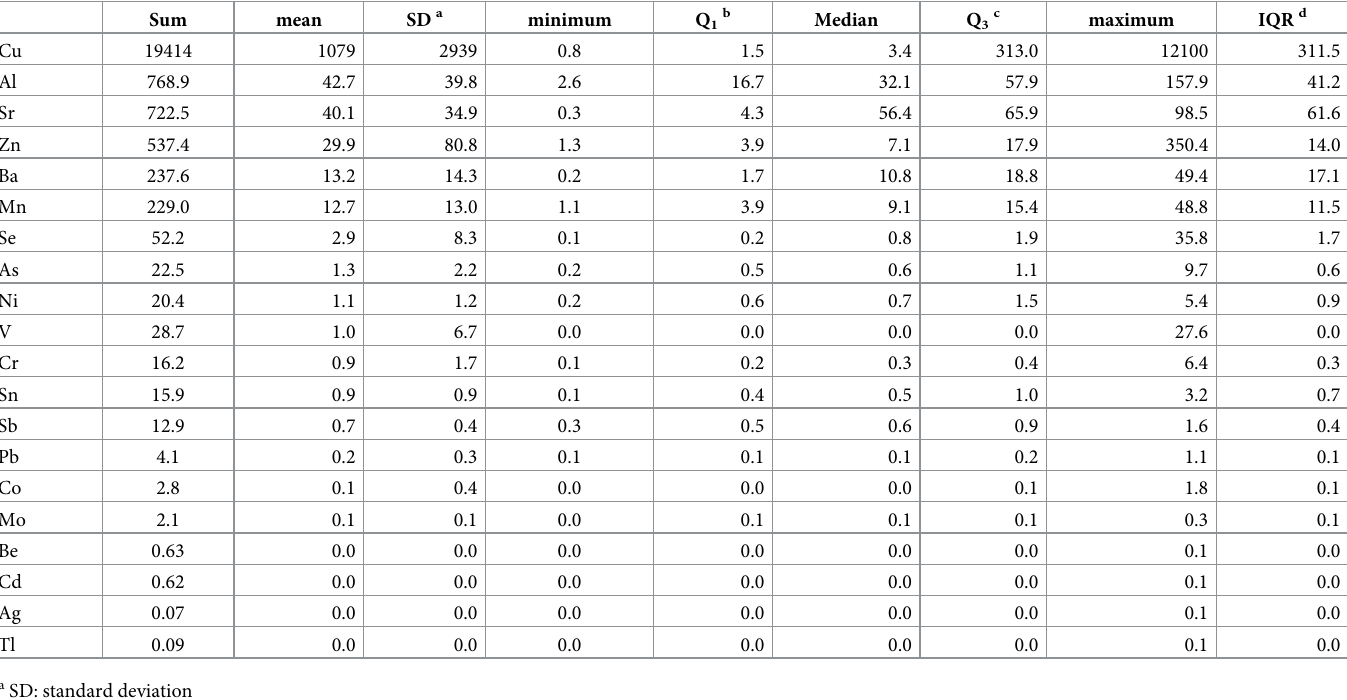
Table 3. Summary statistics associated with 20 metals detected in 13 documented and four undocumented alcoholic beverage brands sold in northern Uganda (in μ g/L). Details are in S1 Table.